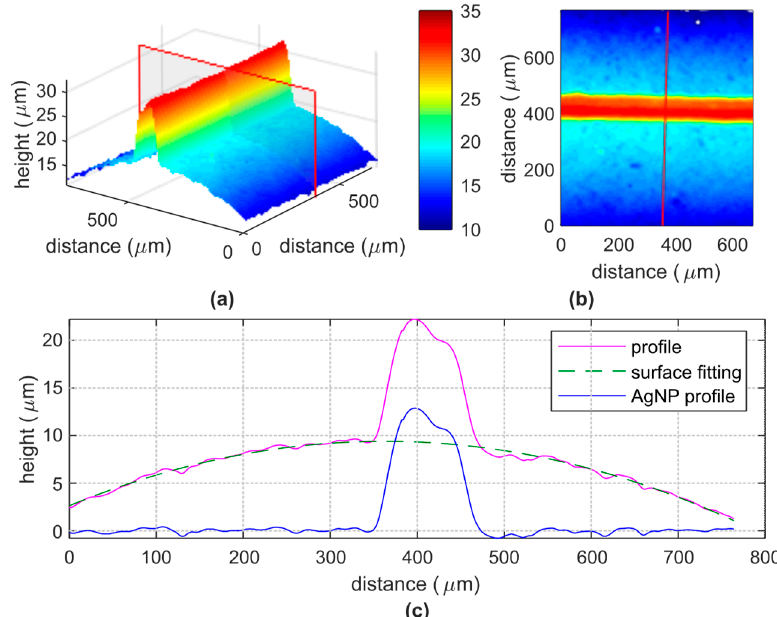
Figure 6. Profile of a portion (0.600 × 700 mm) of one segment of a serpentine device. ( a ) 3D view and plane to determine the cross-section size; ( b ) 2D view and line to determine the cross-section size; ( c ) cross section (magenta line) of the surface (conduit and sensor), with the fitted surface (attributable to the conduit surface) approximated to an arc of circle (green line) and the resulted profile of the only printed segment (blue line).